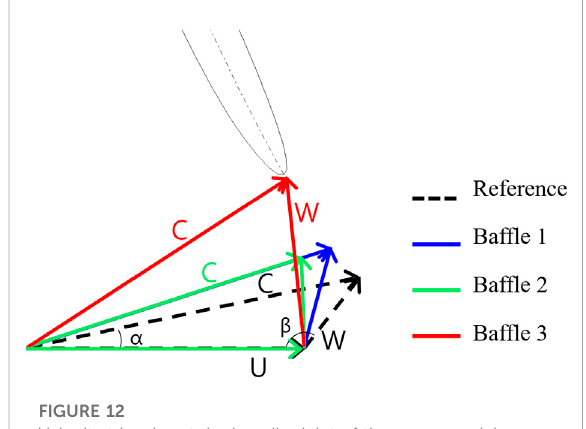
FIGURE 12 Velocity triangles at the impeller inlet of the pump